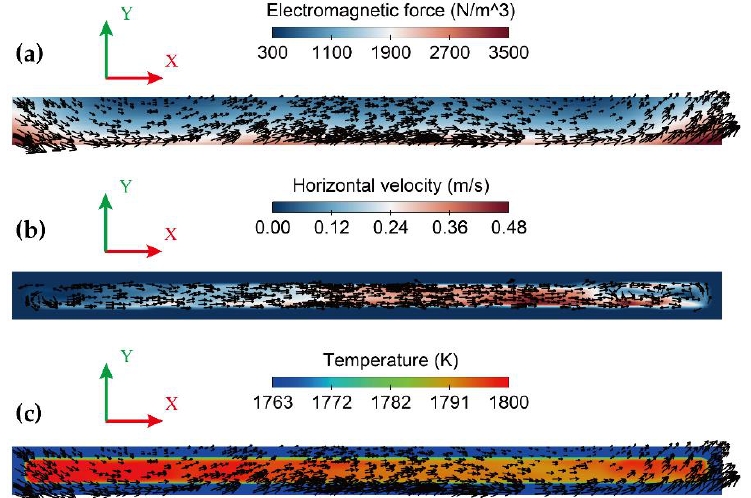
Figure 10. Simulation results in the strand at the mid-height of the SEMS: ( a ) the magnitude and direction of the time-averaged electromagnetic stirring force; ( b ) the magnitude and direction of the horizontal velocity; and ( c ) the temperature distribution. The vector arrow in ( c ) is the electromagnetic stirring force.